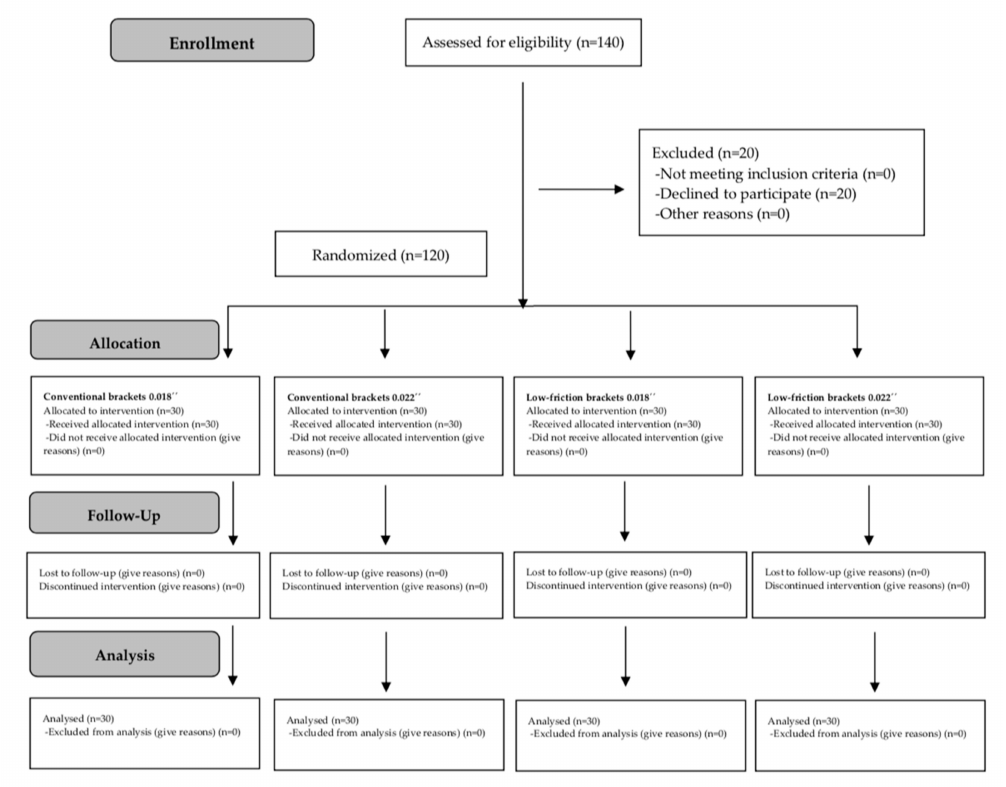
Figure 1. CONSORT flow